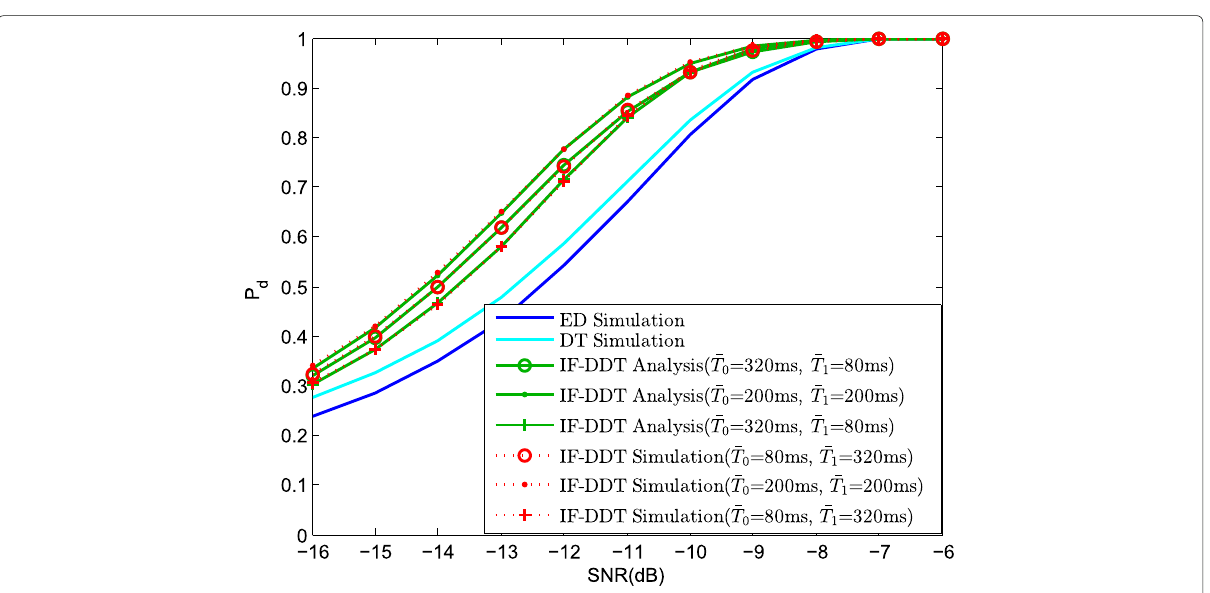
Fig. 7 P d versus SNR for P f ,target = 0.1 and T PU = 400